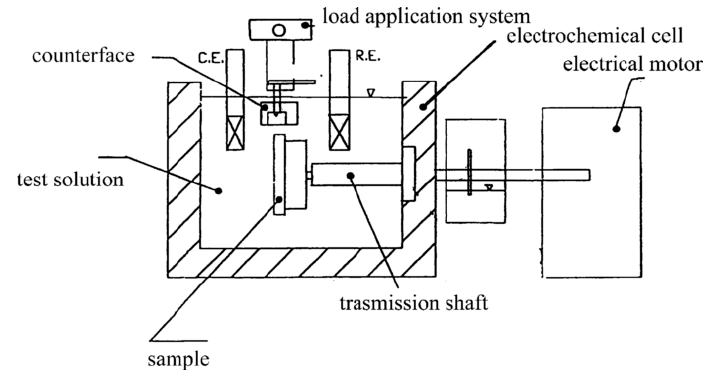
Figure 5. Sketch of the apparatus used for tribo-corrosion tests [6]. Reprinted with permission from ref. [6]. © 2004 Elsevier.